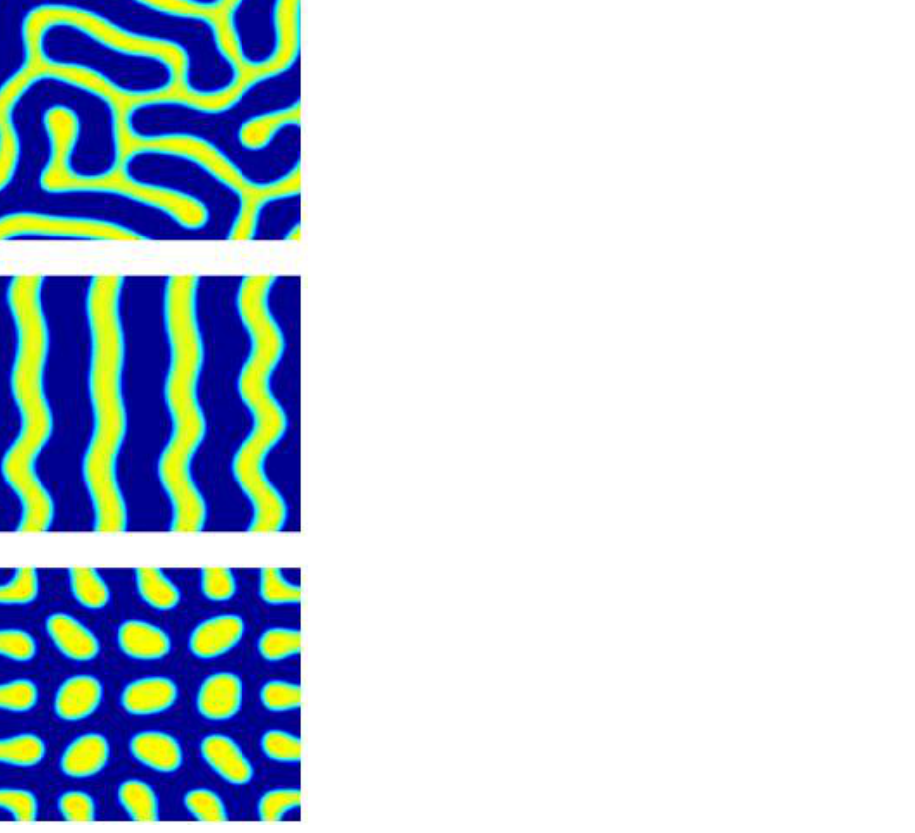
Figure 7. Pattern formation in the Oregonator model studied in Section 5, depending on the initial condition of Oregonator’s state, memristor polarity and stimulation.